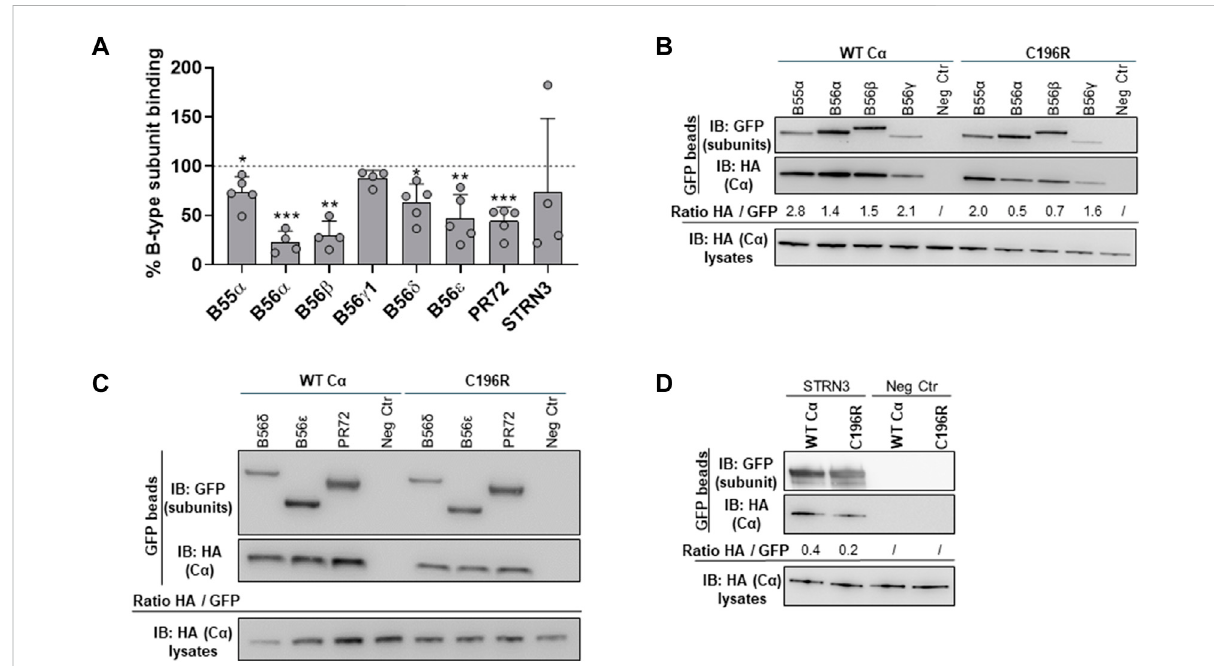
BindingofthePP2A C α p.Cys196ArgvarianttoapanelofregulatoryB-typesubunits.IndicatedGFP-taggedB-typesubunitswereco-expressed with HA-tagged C α WT or C α p.Cys196Arg proteins in HEK293T cells. Binding of the variant or C α WT was assessed in GFP pulldowns by anti-HA immunoblotting. (A) Graphshowingquanti fi edvaluesofB-typesubunitbinding.Eachbarrepresentstheaveragevalue±SDoftheratiosofquanti fi ed anti-HAsignaltoquanti fi edanti-GFPsignalfortheC α p.Cys196ArgvariantincomparisontoC α WT(setat100%ineachexperiment,dottedline). A one-sample t -test (compare to 100%) was used for statistical analysis (n ≥ 4; *, p ≤ 0.05; **, p ≤ 0.01; ***, p ≤ 0.001). (B – D) Representative blots of binding assays. As a negative control (Neg Ctr), C α WT or C α p.Cys196Arg was co-expressed with the pEGFP-C1 vector without insert (only GFP